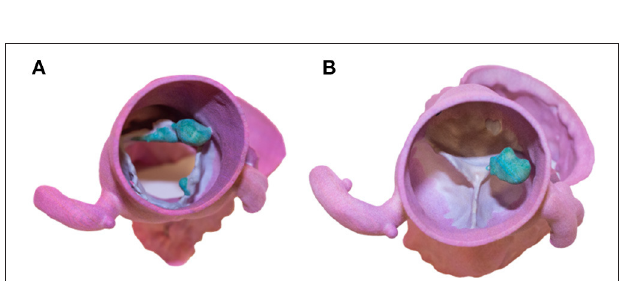
FIGURE 2 | (A) Left ventricular outflow tract view of the pre-operative CT angiogram showing the masses (Yellow arrows) and the thickening of the non-coronary cusp of the aortic valve (White arrow). (B) An XX view of the aortic valve with indicating the mass on the left cusp of the aortic valve (Yellow arrow).